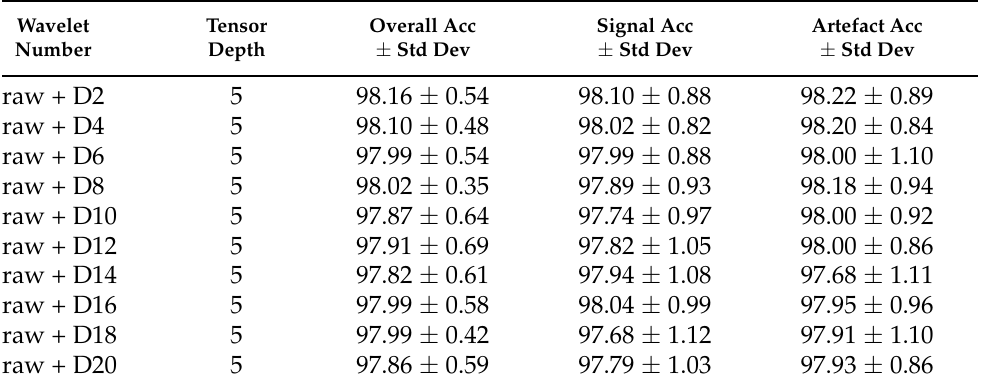
Table 12. Smaller-scale CNN model performance for various single wavelet transformations applied to input data. Input tensor composed of a greyscale image and wavelet image components ( a , v , h , d ) set in a sequence which gives a tensor depth of 1 + 4. Results have been estimated using repeated k-fold validation (5 rounds with 5 folds each). Wavelet Tensor Overall Acc ± Std Number Depth